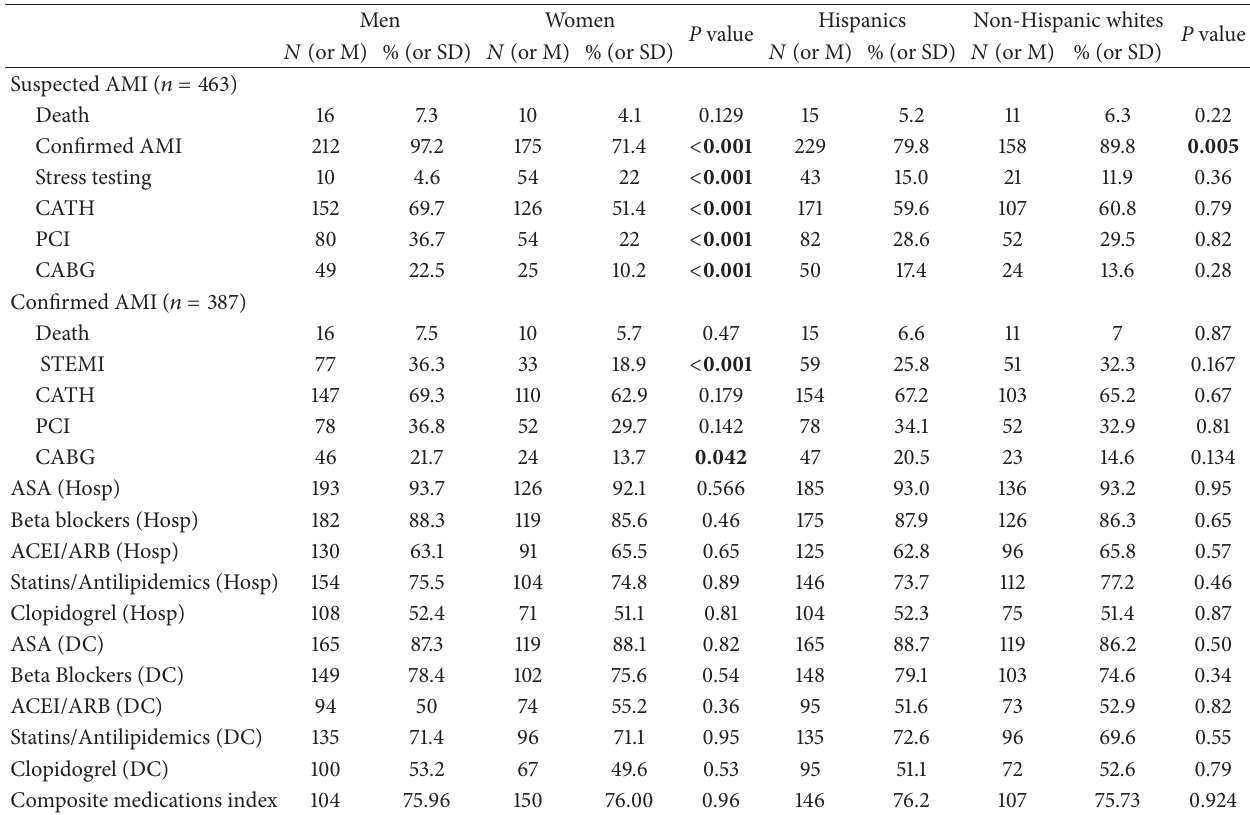
Table 2: Selected outcomes in patients admitted with a suspected (𝑛 = 463) and confirmed (𝑛 = 387) Acute Myocardial Infarction according to gender and race ethnicity.